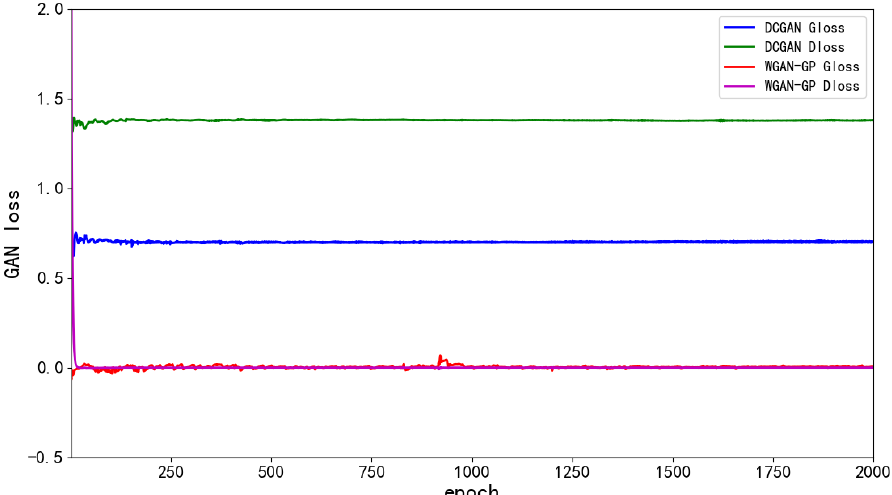
Figure 2. The losses of the generator and discriminator of the proposed DCGAN with increasing training